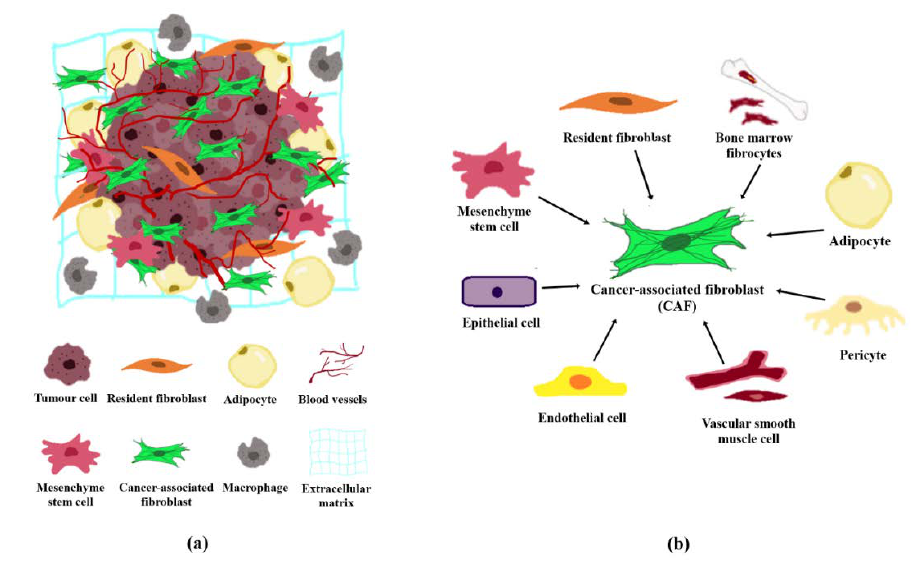
Figure 1. Tumour microenvironment and the origin of CAFs. ( a ) Cellular and non-cellular components in the tumour microenvironment comprising of fibroblasts, adipocytes, macrophages, endothelial cells and the extracellular matrix. ( b ) CAFs may originate from normal resident fibroblasts, mesenchymal stem cells, epithelial cells, endothelial cells, vascular smooth muscle cells, pericytes, adipocytes and / or bone marrow fibrocytes.